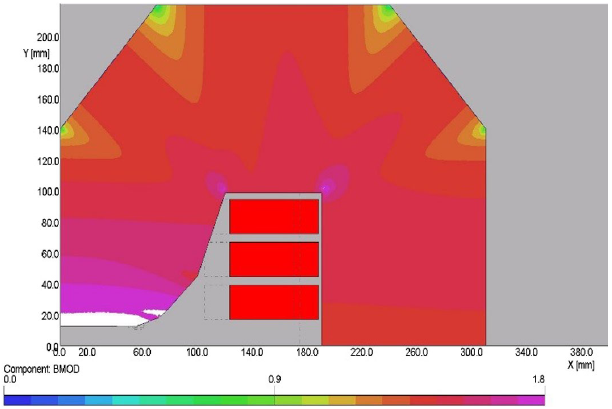
FIG. 8. FeSi magnet 2D flux density simulation with an increased yoke cross section to achieve a center field of 1.8